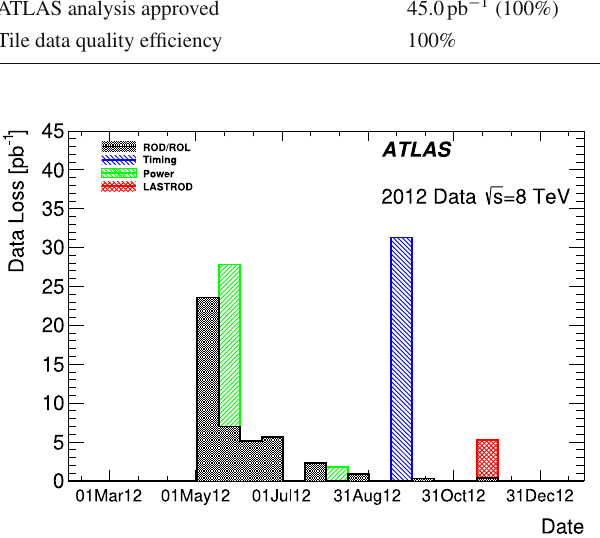
Fig. 20 The sources and amounts of integrated luminosity lost due to Tile Calorimeter data quality problems in 2012 as a function of time. The primary source of luminosity losses comes from the stop-less read- outlink(ROL)removalintheextendedbarrelsaccountingfor45.2pb − 1 of this loss. Power cuts or trips of the 200V power supplies account for 22.6pb − 1 .Thelast4.9pb − 1 oflossesstemfromLaserCalibrationROD (LASTROD) busy events. The loss of 31.3pb − 1 due to a − 25ns timing shift in EBC are recovered after the data are reprocessed with updated timing constants. Each bin in the plot represents about two weeks